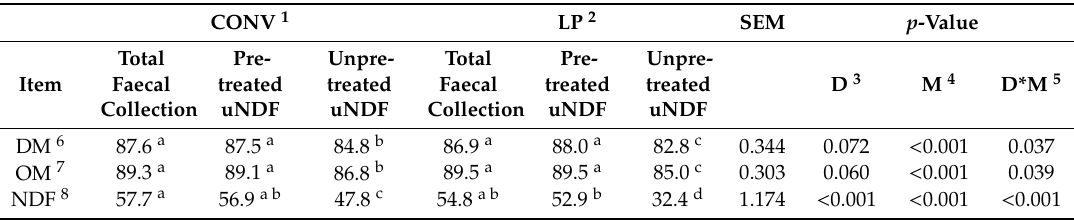
Table 1. Digestibility values (%) of the two diets measured with the undigested neutral detergent fibre (uNDF) method with and without the neutral detergent solution and α -amylase pre-treatment versus the total faecal collection method.